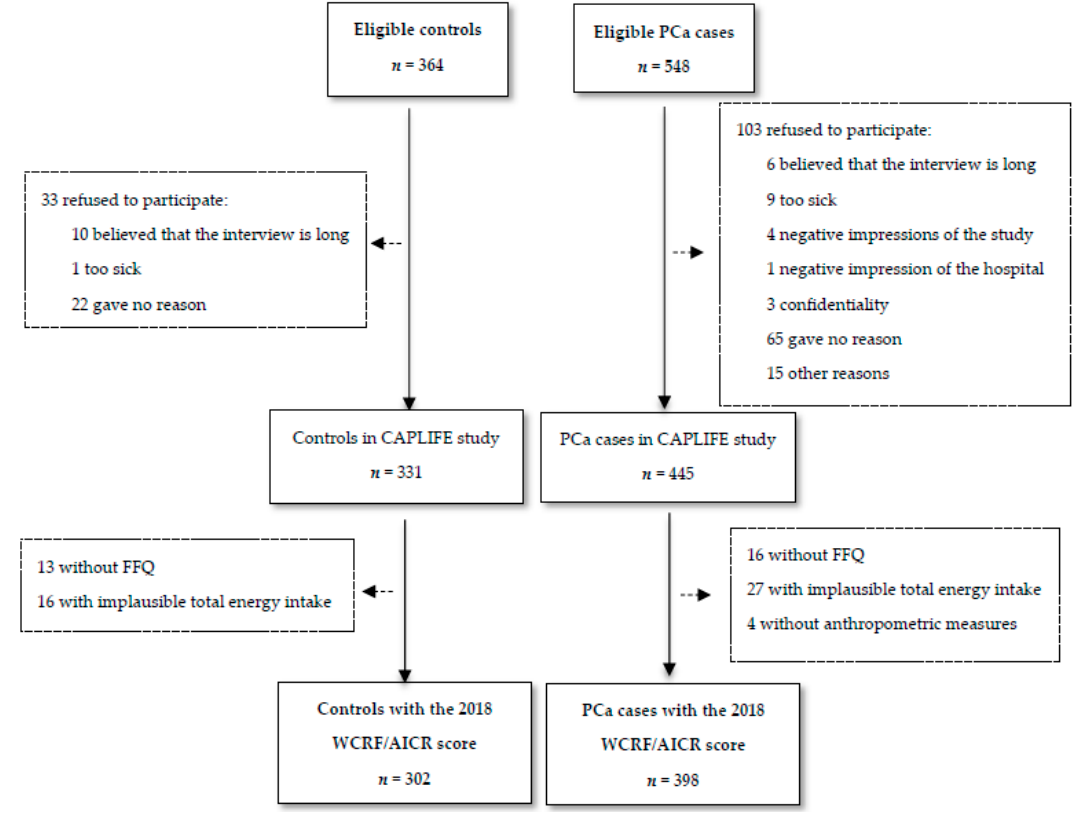
Figure 1. Flow-chart CAPLIFE